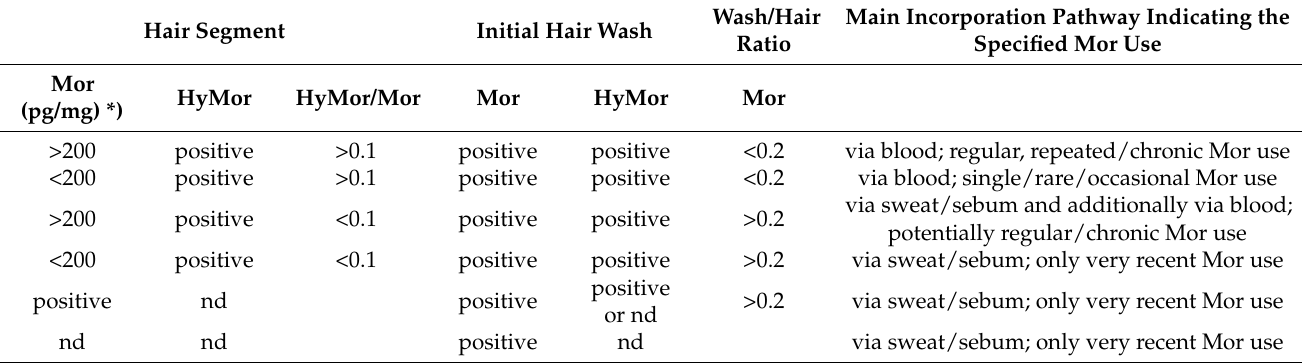
Table 5. Summary and recommendations for interpretation of short hair segment results tested in morphine-positive cases. Hair